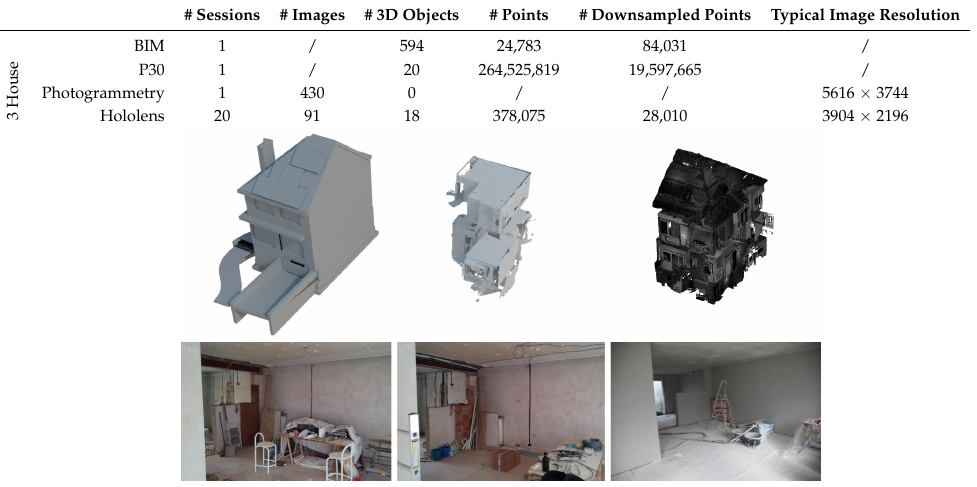
Table 2. Overview of the provided reference data of test case 3.